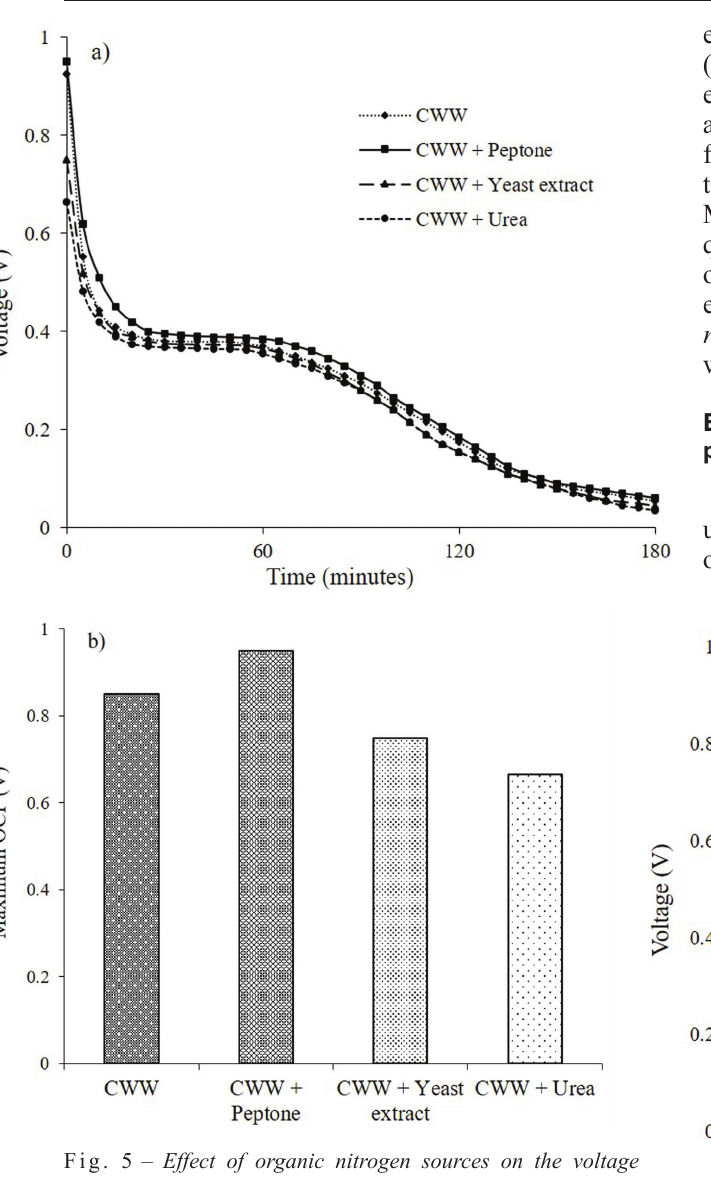
Fig. 5 – Effect of organic nitrogen sources on the voltage output (a), and the open-circuit potential (b) of the CW-MFC